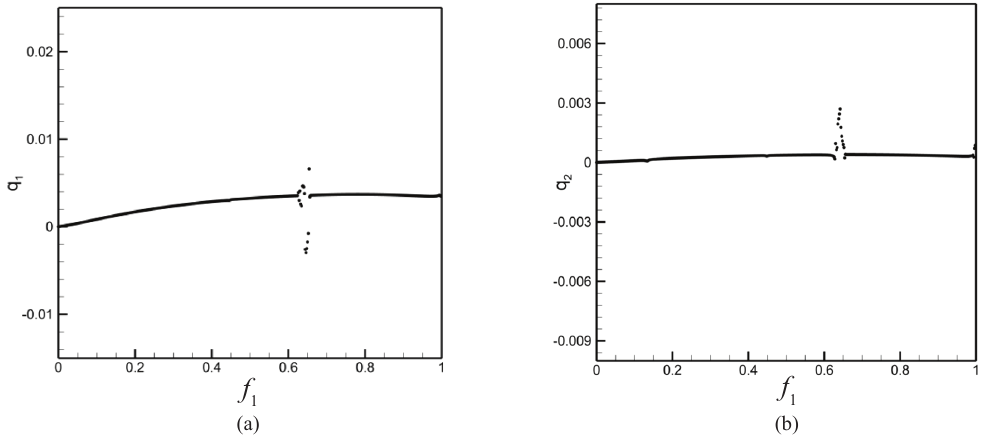
Fig. 8. Bifurcation diagrams of Poincaré points for increasing forcing amplitude on the system with c = 0 . 2 ,α = 10 and β = 2